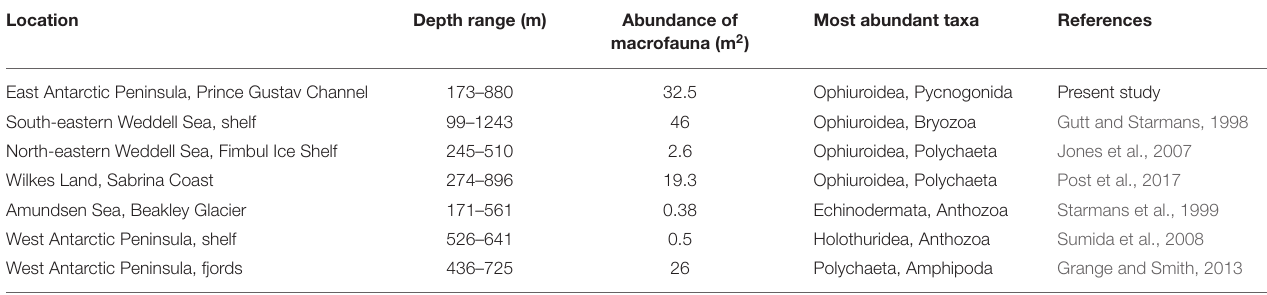
TABLE 7 | Comparison of abundance and key taxa based on photographic studies at comparative depths on Antarctica’s continental shelf.